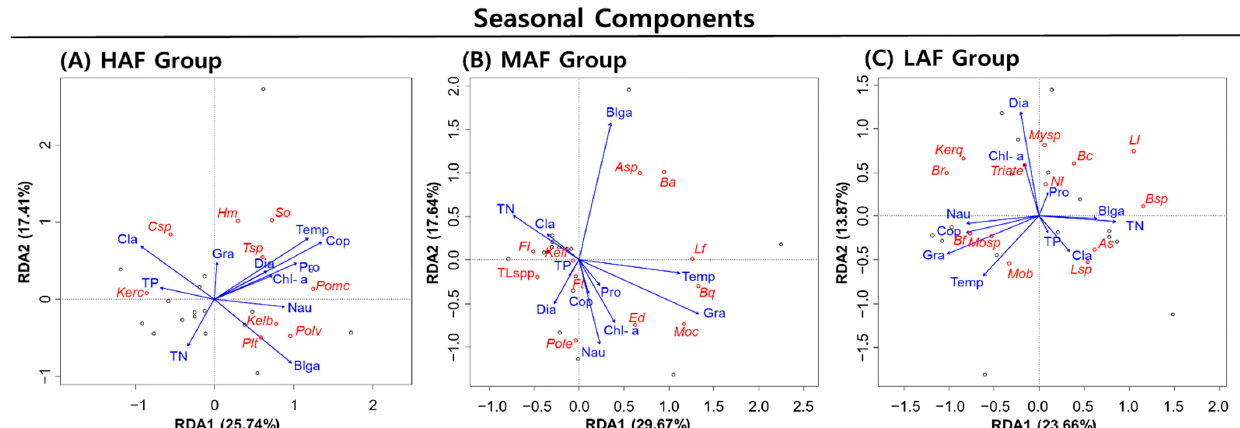
Figure 6. Redundancy analysis of the seasonal component (derived from the time series of the abundance estimates of three rotifer groups) and environmental factors. ( A ) High abundance and frequency rotifers group, ( B ) Middle abundance and frequency rotifers group, ( C ) Low abundance and frequency rotifers group.